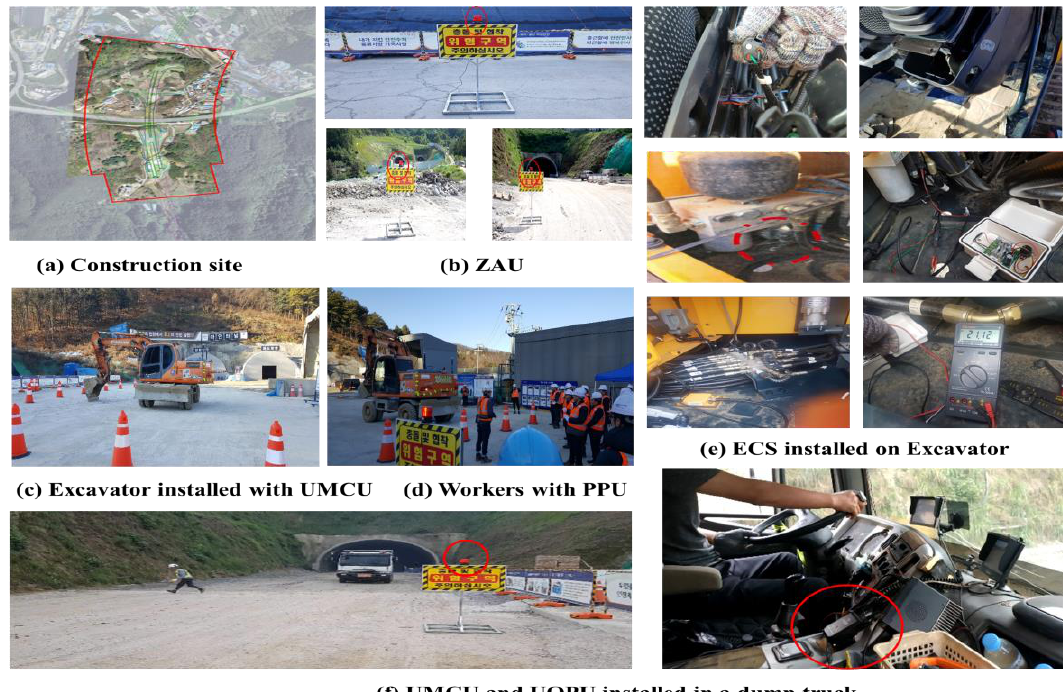
Figure 16. Field experiment environment (construction site).